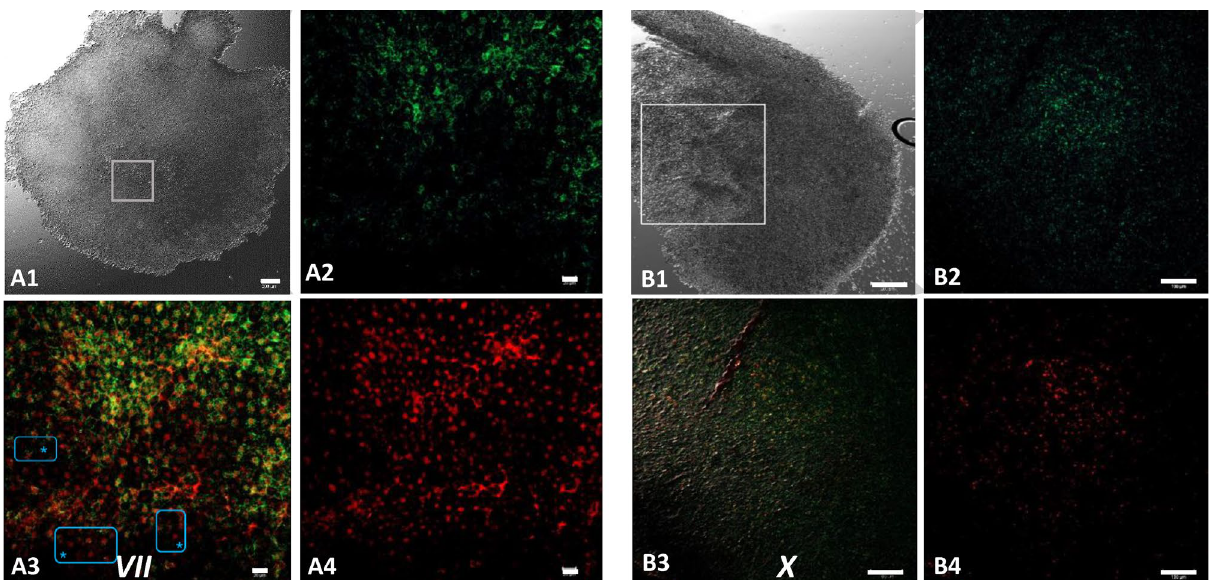
Figure 9. Bucky ball and CVH are no longer co-localized within the nuclear region of primordial germ cells during the area pellucida formation. 7A, in EGK VII embryos, at the beginning of area pellucida formation, Bucky ball (green) in the center of the germinal disc diffused back into the cytoplasm ( A2 ), while CVH (red, A4 ) is contained predominantly in the nuclei. This is visualized clearly in the overlay ( A3 ) as a red center of the germline predisposed cells surrounded by the green Bucky ball fluorescence. Blue frames with asterisk indicate only CVH labeled without Bucky ball at the lateral edges of the central region. DAPI as nuclear marker visualizes the central concentration of the germline cells and as white overlay the nuclear localization of CVH and DAPI in the germline cells. This pattern is stable until oviposition at stage X ( B ). Scales in ( A1 ) = 200 µm, ( B1 ): 500 µm, ( A2–A4 ) 20 µm, ( B2–B4 ): 100